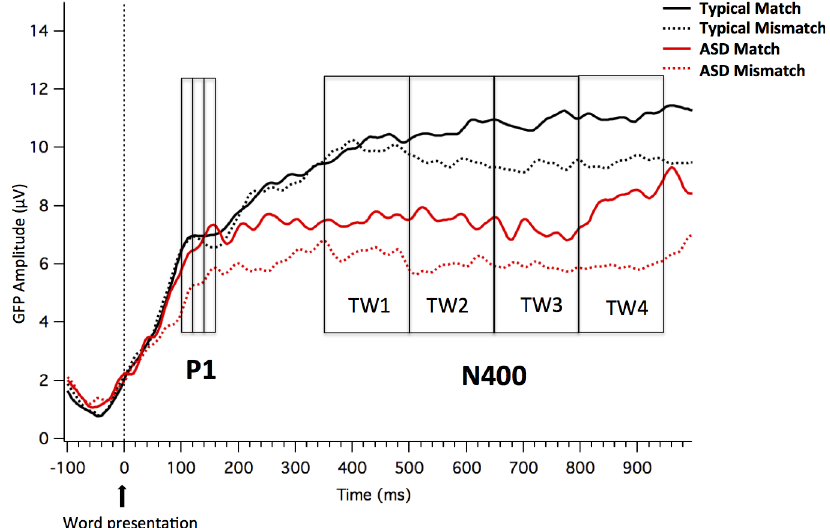
Fig 5. GFP for auditory evoked potentials. GFP measures time-locked to the word for the two groups (Neurotypical and ASD children) and the two conditions (Match and Mismatch).